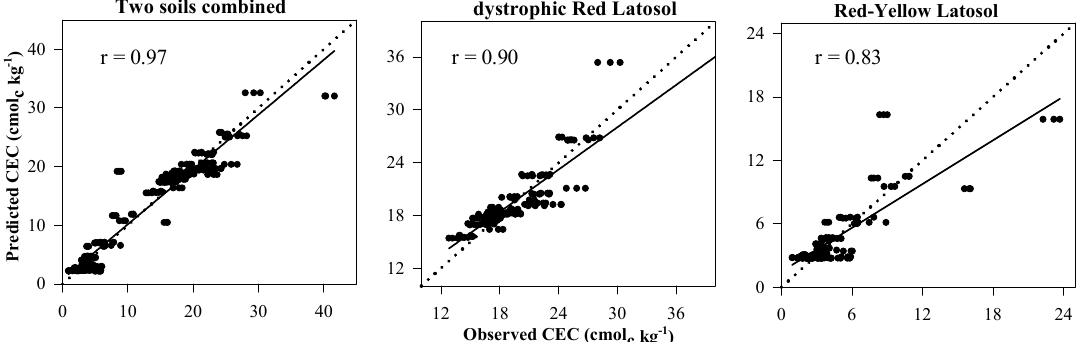
Figure 4. Cation exchange capacity (CEC) predicted by Equation (1) (soil CEC = a + b CEC biochar weight + c CEC soil weight ) and CEC determined by the sodium acetate method.